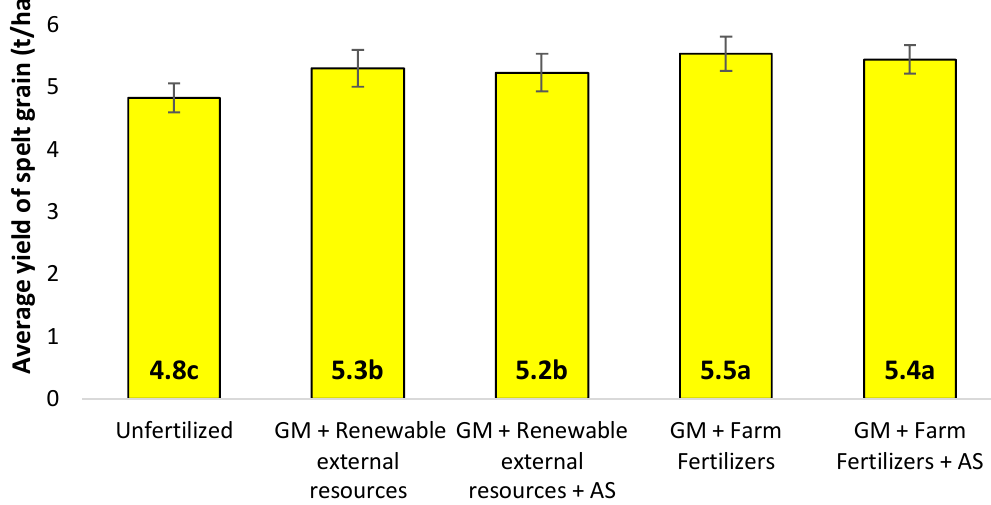
Figure 5. Grain yield of spelt (observed treatments, 2017). Error bars represent the standard error (SE). Different letters mean statistical difference ( p ≤ 0.5).